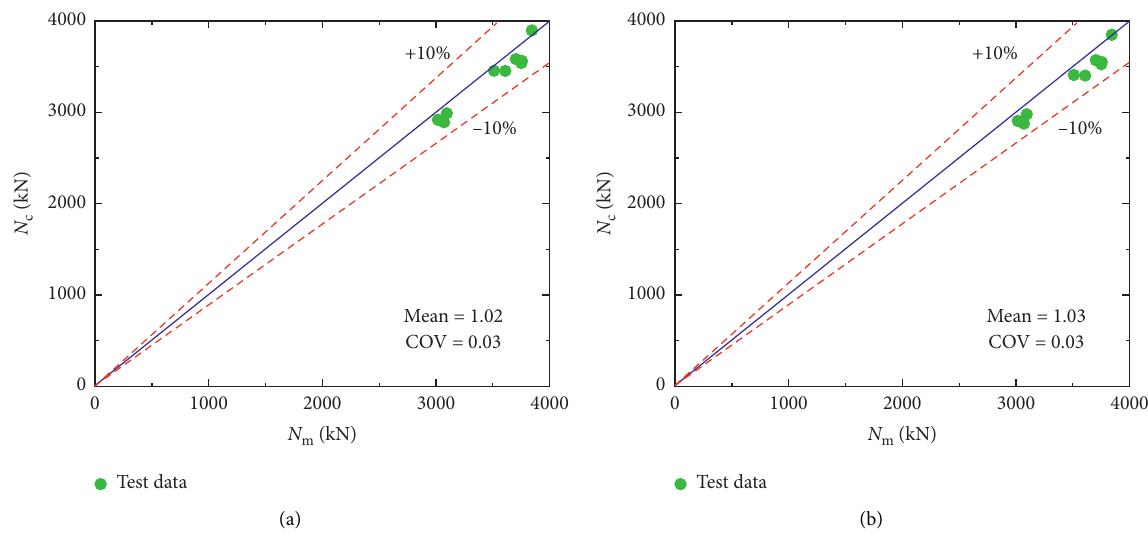
Figure 16: Comparison of experimental results in the literature [39] with results calculated using the (a) proposed method and (b) simplified